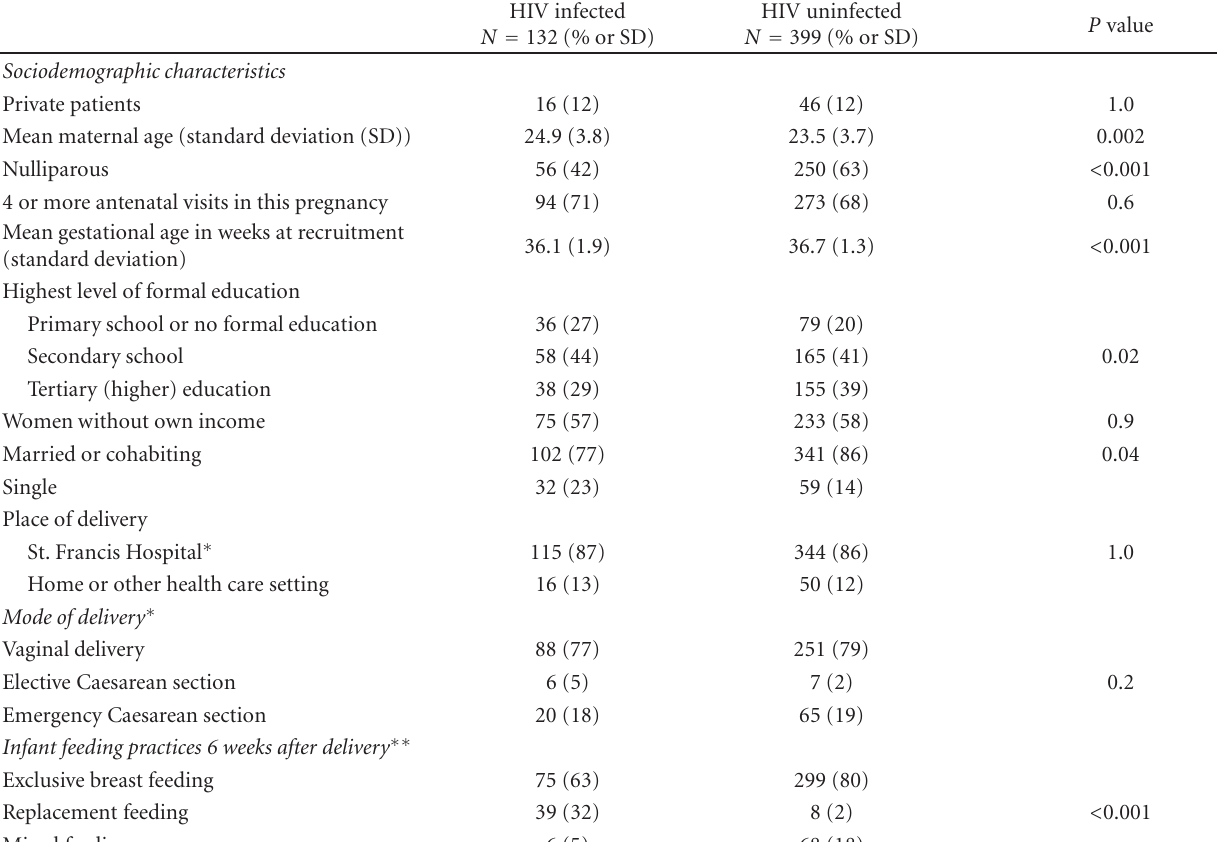
Table 1: Characteristics of HIV-infected and uninfected women in the cohort study.